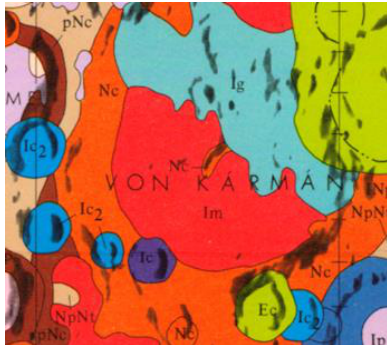
Figure 2 Geologic map of Von Kármán region (https://www.lpi.usra.edu/resources/mapcatalog/usgs/)